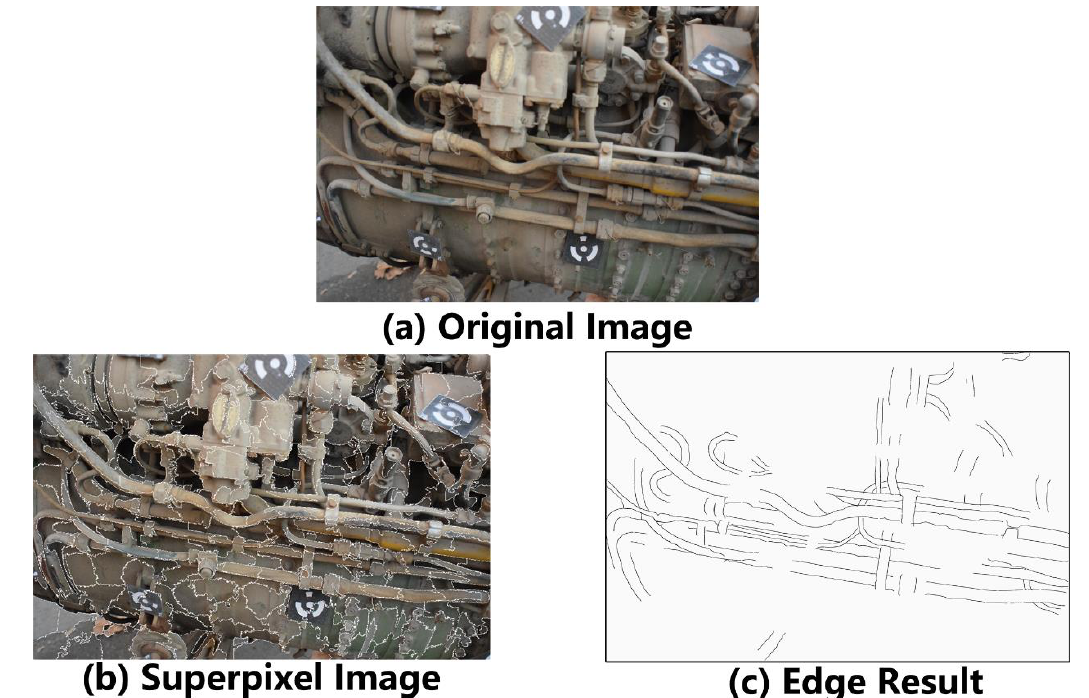
Figure 6. Input data and results of edge detection.